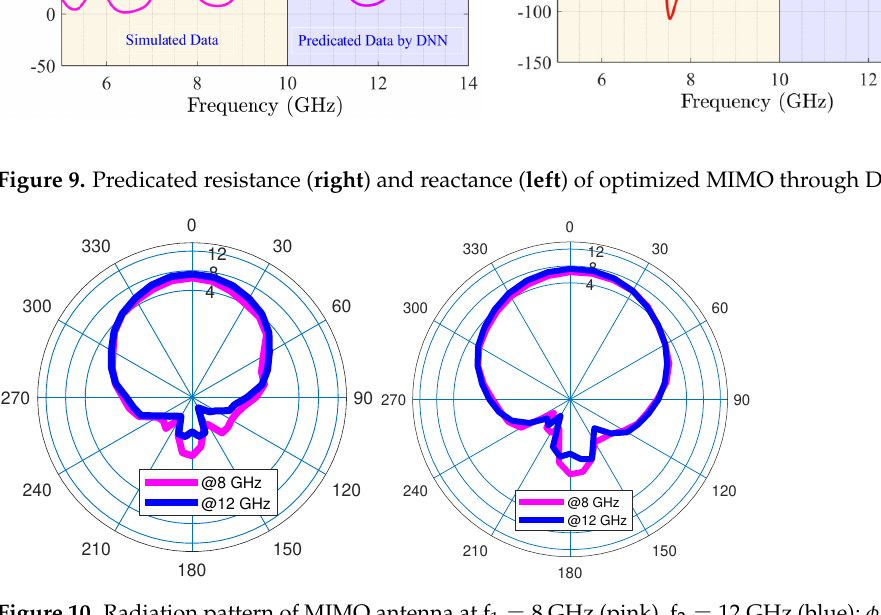
Figure 10. Radiation pattern of MIMO antenna at f 1 = 8 GHz (pink), f 2 = 12 GHz (blue); φ = 0 ( left ), φ = 90 ◦ ( right